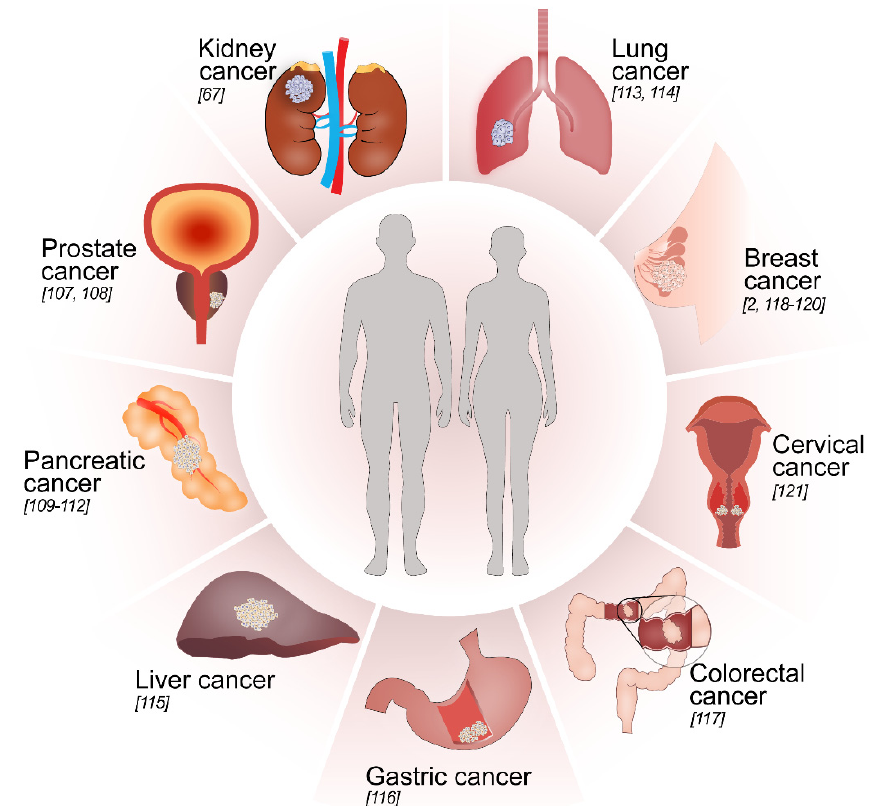
Figure 4. A graphical illustration of several organs where TGF- β and hypoxia contribute to tumor aggressiveness; included are references to studies that have investigated synergistic cooperation between TGF- β and hypoxia in respective cancer types. See also Table 1.